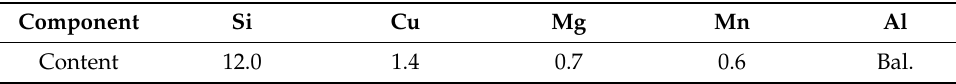
Table 1. Chemical compositions of Al-12Si alloy (wt%). Component